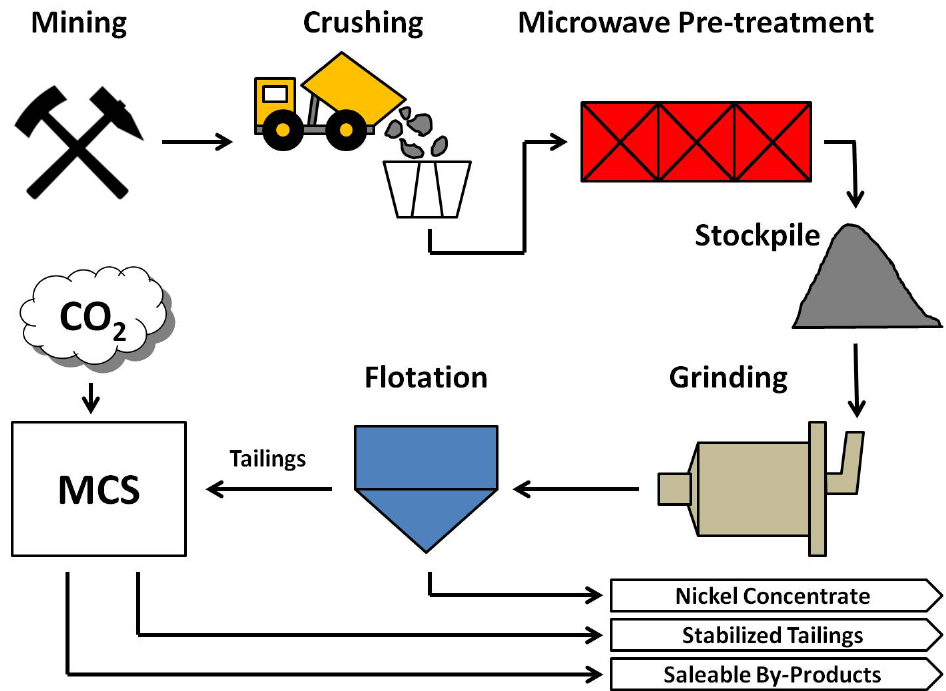
Figure 1. Schematic of a combined mineral processing and mineral carbon storage (MCS) process with microwave pretreatment.